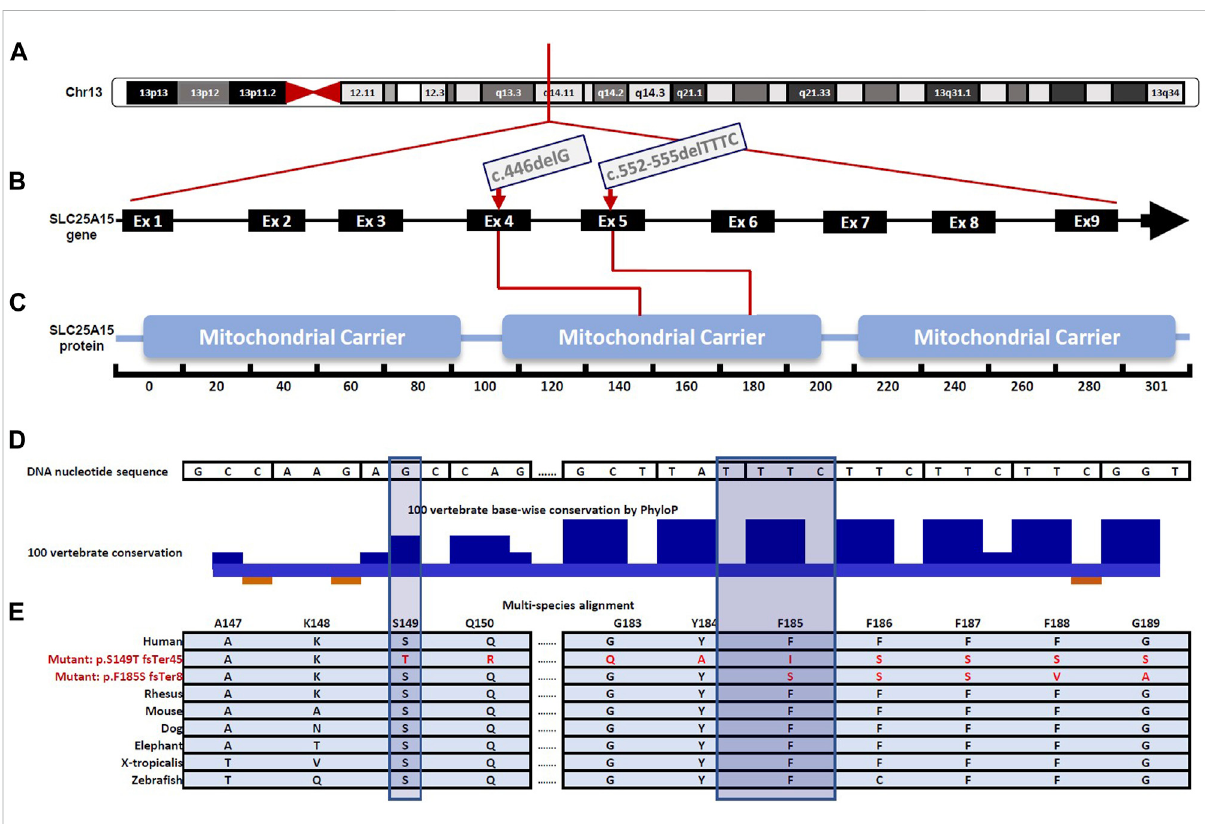
FIGURE 1 Schematic illustration for gene and protein domain structure of SLC25A15 highlighting variants identi fi ed in the Palestinian patient cohort affected by Hyperornithinemia-Hyperammonemia-Homocitrullinuria (HHH) Syndrome, (A) A simpli fi ed illustration of SLC25A15 gene location on chromosome13,speci fi callyinthe13q14.11region (B) Genediagramshowingtheexon-intronorganizationofthe SLC25A15 gene(NNM_014252.4), comprised of 9 exons and is 2.93 kb in length. The c.446delG, (p.Ser149ThrfsTer45) and the c.552-555delTTTC, p (Phe185SerfsTer8) variants are located in exon 4 and exon 5, respectively (red arrows) (C) SLC25A15 gene encodes a 301 amino acid protein predicted to contain three mitochondrial carrier domains, essential for the ef fi cient transport of ornithine across the inner mitochondrial membrane during urea cycle (D) Zoomed view of the molecular region encompassing the p. Phe185SerfsTer8 and the p. Ser149ThrfsTer45 variants. The sites of the two variants are highlyconservedamonghumansandothervertebratesasdepictedusingthePhyloPalgorithmintheUCSCconservationtrackacross100vertebrate species(shadowedbarsindicate theaminoacidswhere reading framechanges haveoccurred) (E) Multi-species alignment showing conservation of part of the molecular region encompassing the p (Phe185SerfsTer8) and p (Ser149ThrfsTer45)